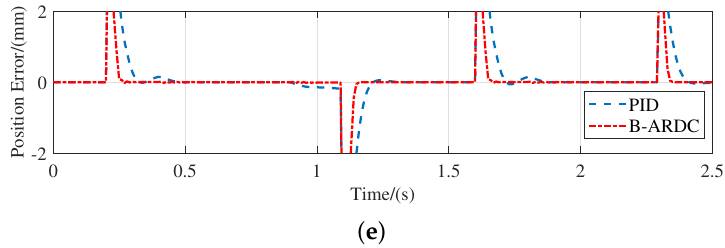
Figure 17. Performance comparison of double-loop controllers: ( a ) Clutch Torque; ( b ) Torque Error; ( c ) Clutch Position (PID+PID); ( d ) Clutch Position (AFFC+B-ARDC); ( e ) Position